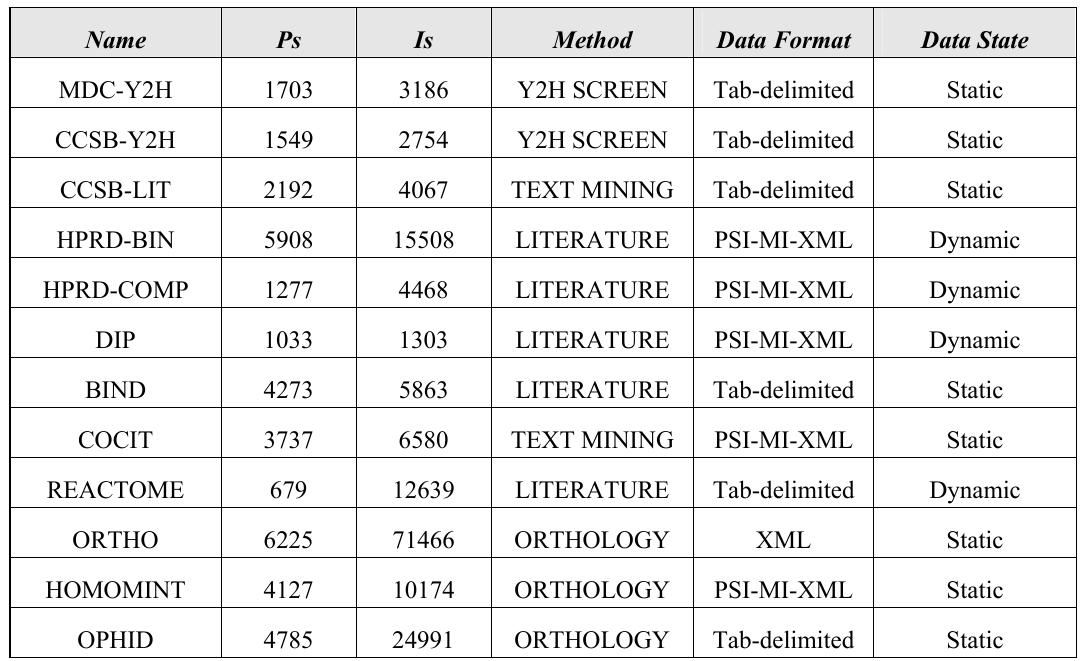
Table 1: An overview of all interaction maps included in the UniHI database. The abbreviations ‘ Ps’ and ‘ Is’ are the total number of proteins and interactions in the corresponding databases. The column ‘Method’ lists the approaches used for generating the interaction maps. The column ‘Data Format’ describes the formats of the available data. The column ‘Data State’ provides information about state of the included interaction